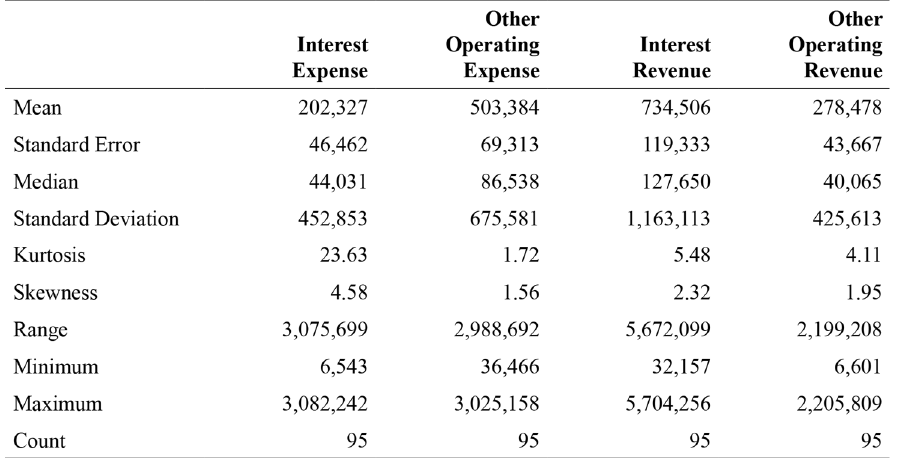
Figure A7. Summary statistics.